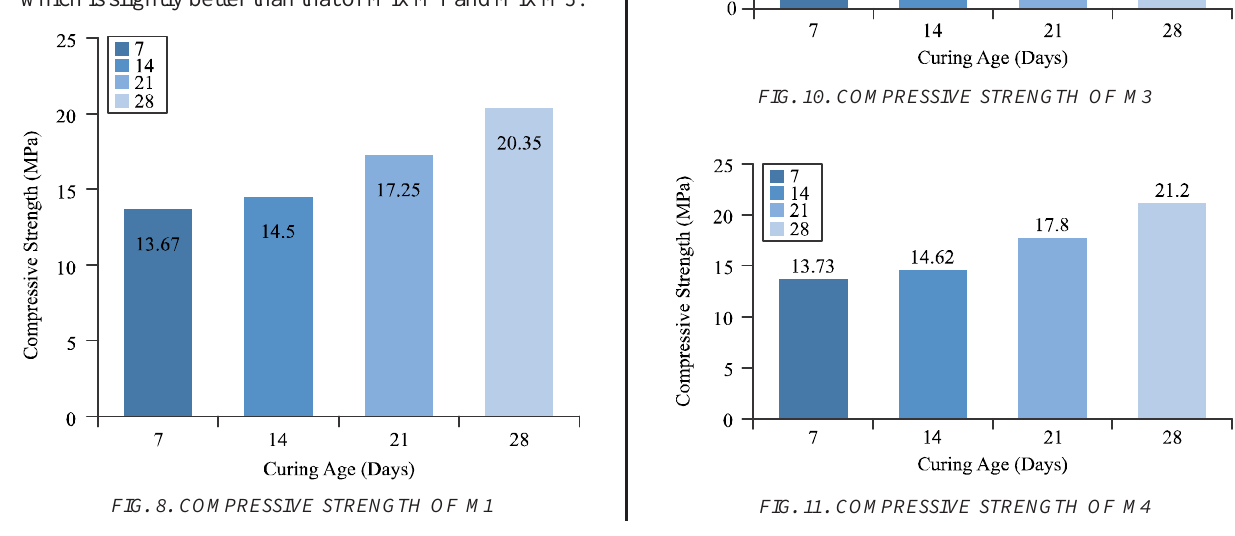
FIG. 8. COMPRESSIVE STRENGTH OF M1